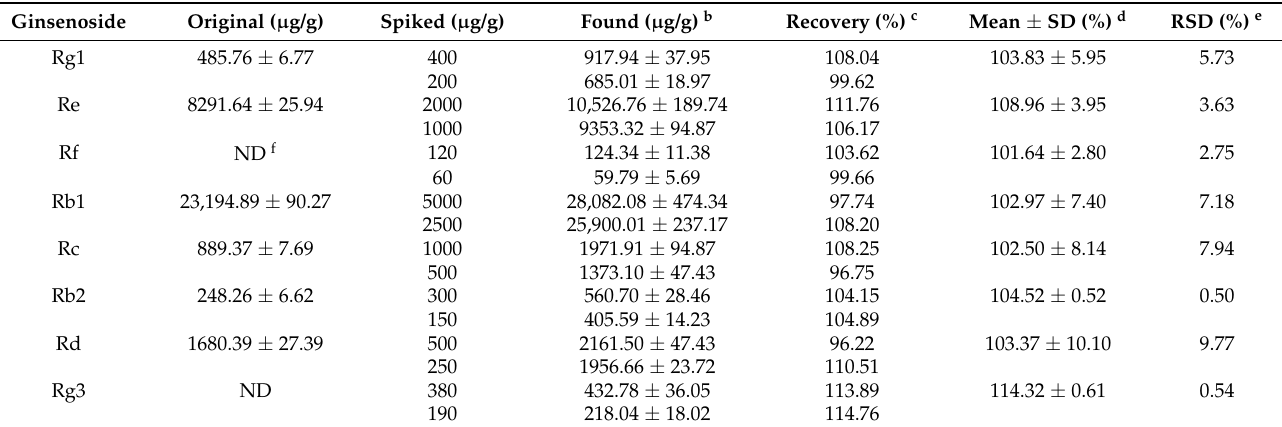
Table 3. The recovery data of ginsenosides by HPLC-DAD-ESI-MS a . Ginsenoside